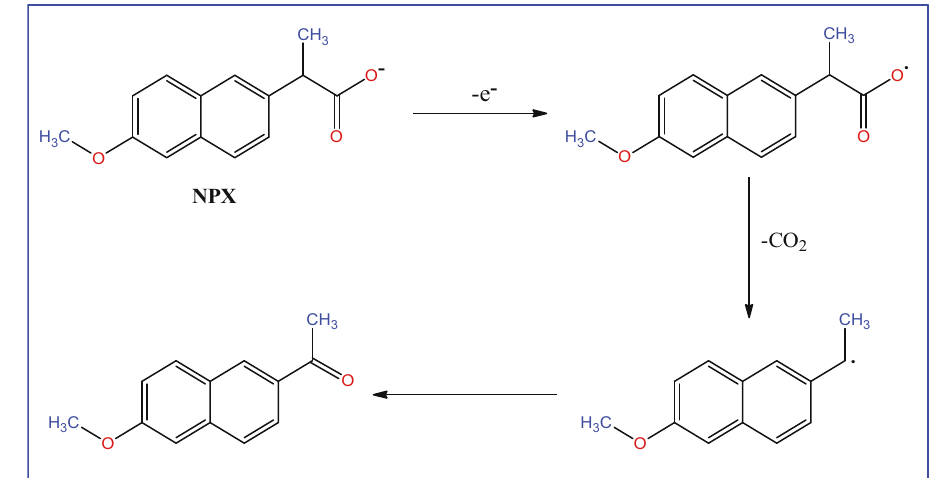
Scheme 1: Proposed mechanism of the electrochemical oxidation of